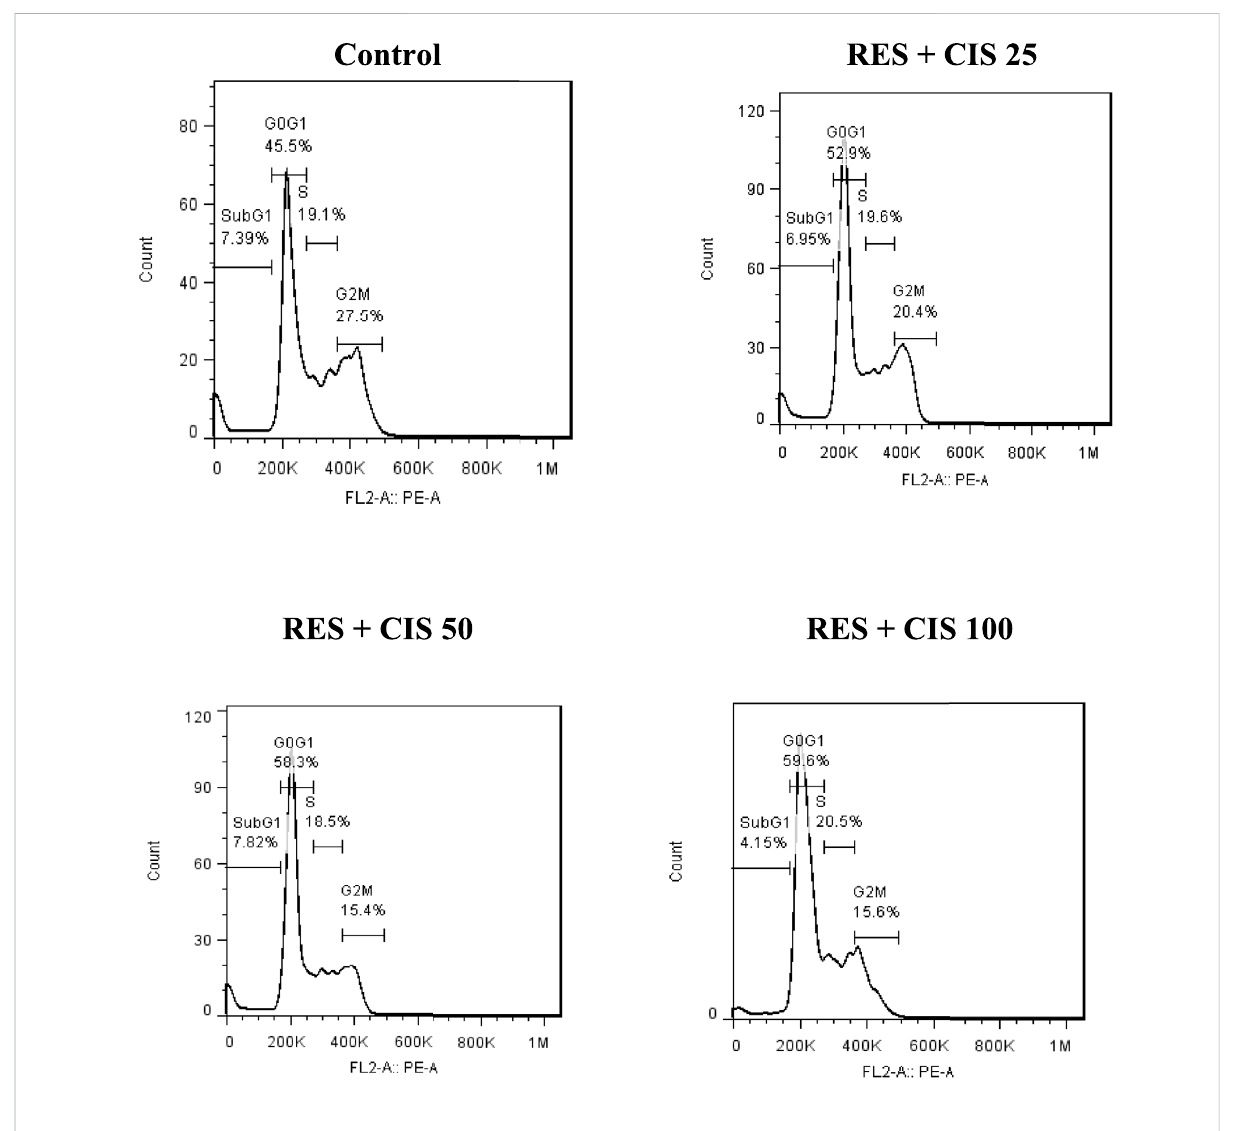
FIGURE 4 Effect of resveratrol (RES) and different concentrations of cisplatin (CIS) (25, 50 and 100 μ g/ml) on cell cycle distribution